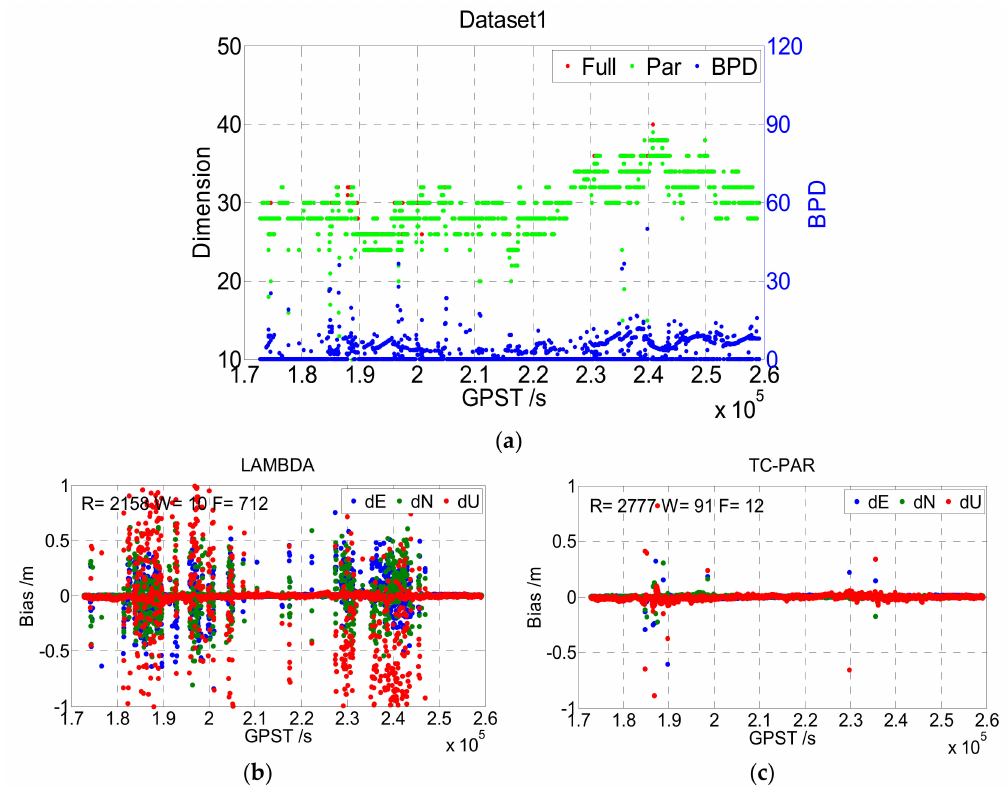
Figure 7. Dimensions of the ambiguity full set / subset and BPD value ( a ), and the baseline deviation sequence of LAMBDA ( b ) and TC-PAR ( c ) in Dataset1. R, W, and F denote the right fixed epoch, wrong fixed epoch, and float epoch, respectively.